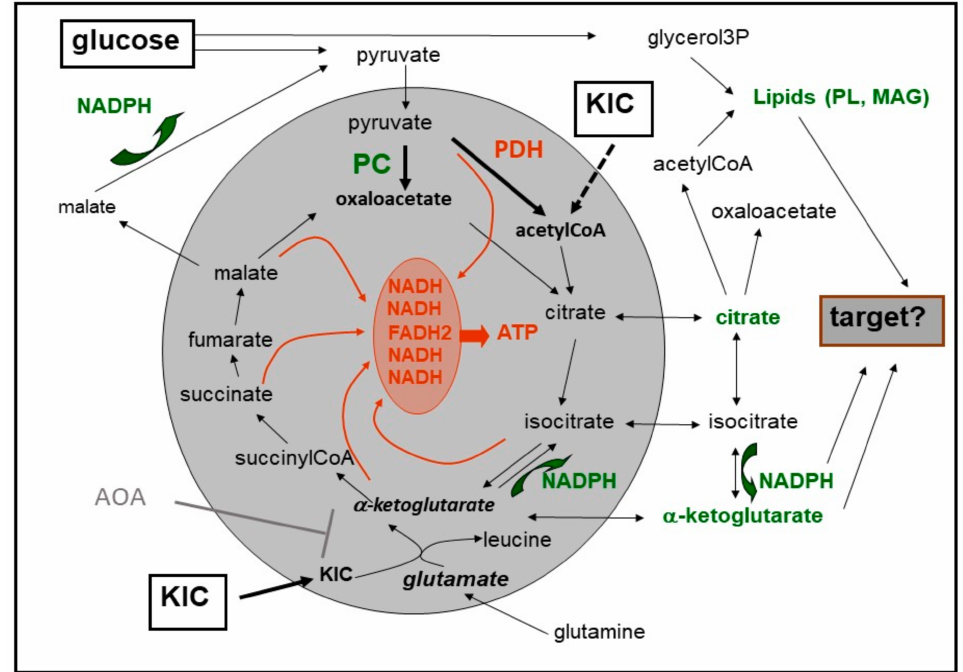
Figure 1. Both glucose and KIC exert an anaplerotic effect on the citric acid cycle in beta cells. Glucose-derived pyruvate is either metabolized by pyruvate dehydrogenase (PDH) to acetyl-CoA or by pyruvate carboxylase (PC) to oxaloacetate. KIC can be degraded, which yields acetyl-CoA. It can also be transaminated with glutamate, which yields alpha-ketoglutarate and leucine. This reaction is essential for the insulinotropic effect since inhibition of transamination by AOA inhibits KIC-induced insulin secretion. The carbon which is fed into the citric acid cycle is derived from glutamate, which, in turn, is generated from endogenous glutamine. The red color marks reactions which support oxidative phosphorylation, the green color marks metabolites and reactions with potential relevance for glucose-dependent amplification. Abbreviations: AOA = aminooxyacetate, KIC = alpha-ketoisocaproic acid, MAG = monoacylglycerol, PL =